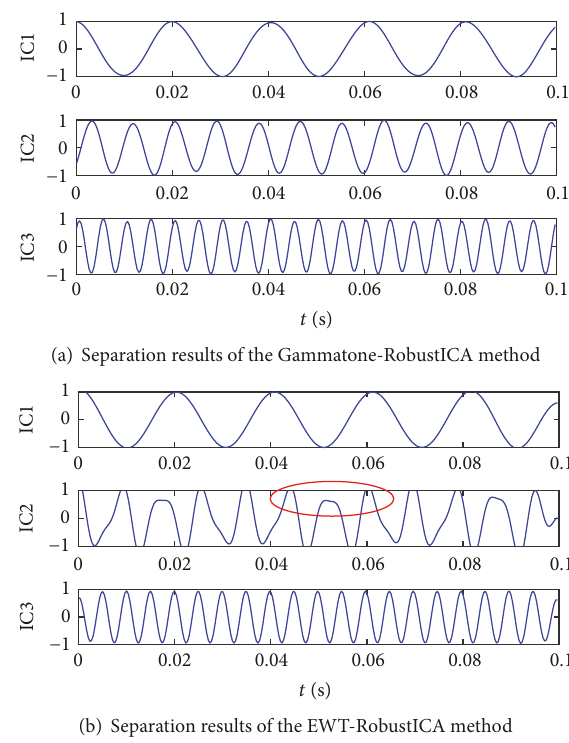
Figure 5: Comparison of simulation signal separation results.